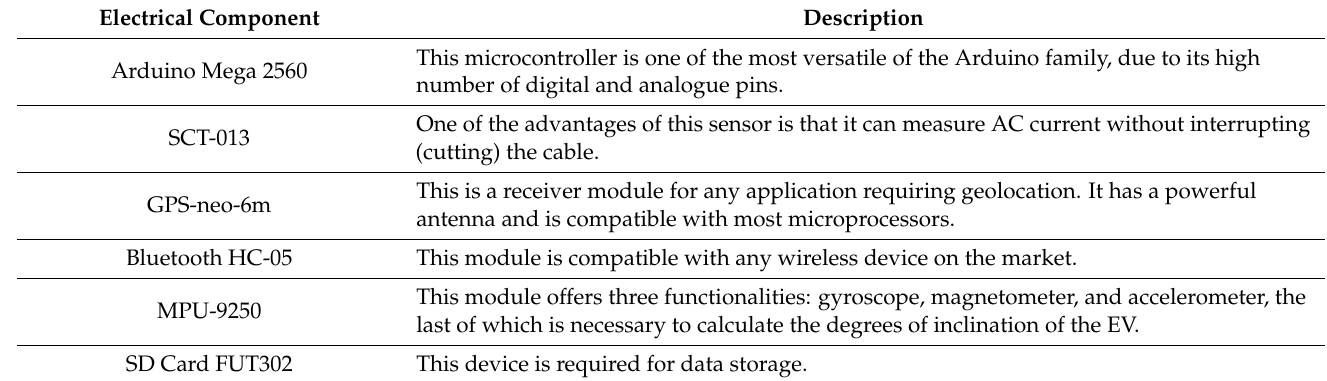
Figure 1. Hardware architecture developed for the EV. Table 1. Description of components